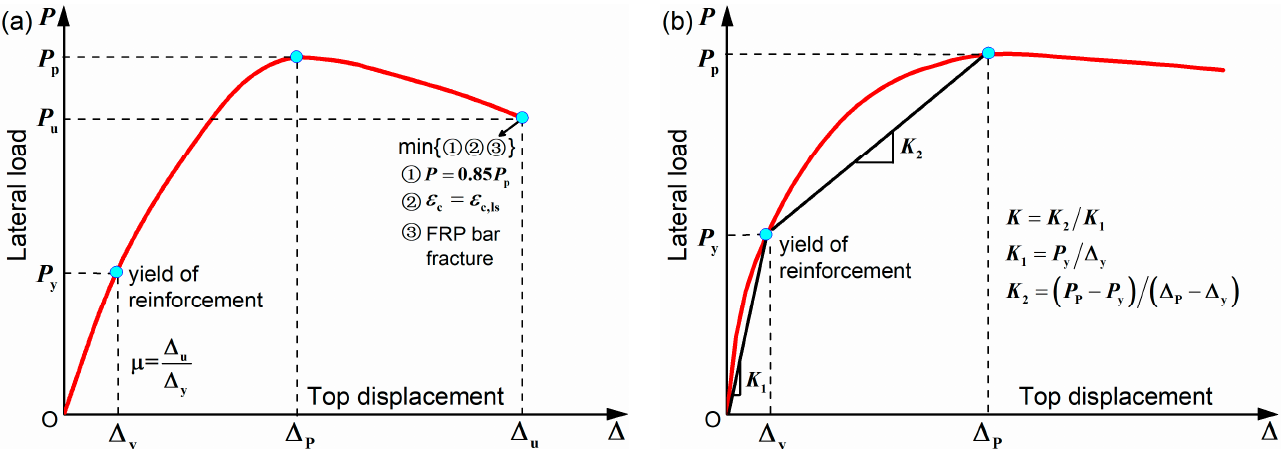
Figure 12. Definition of the characteristic parameters of envelope curves: ( a ) yield, peak, ultimate parameters and displacement ductility coefficient; ( b ) post-yield stiffness ratio.